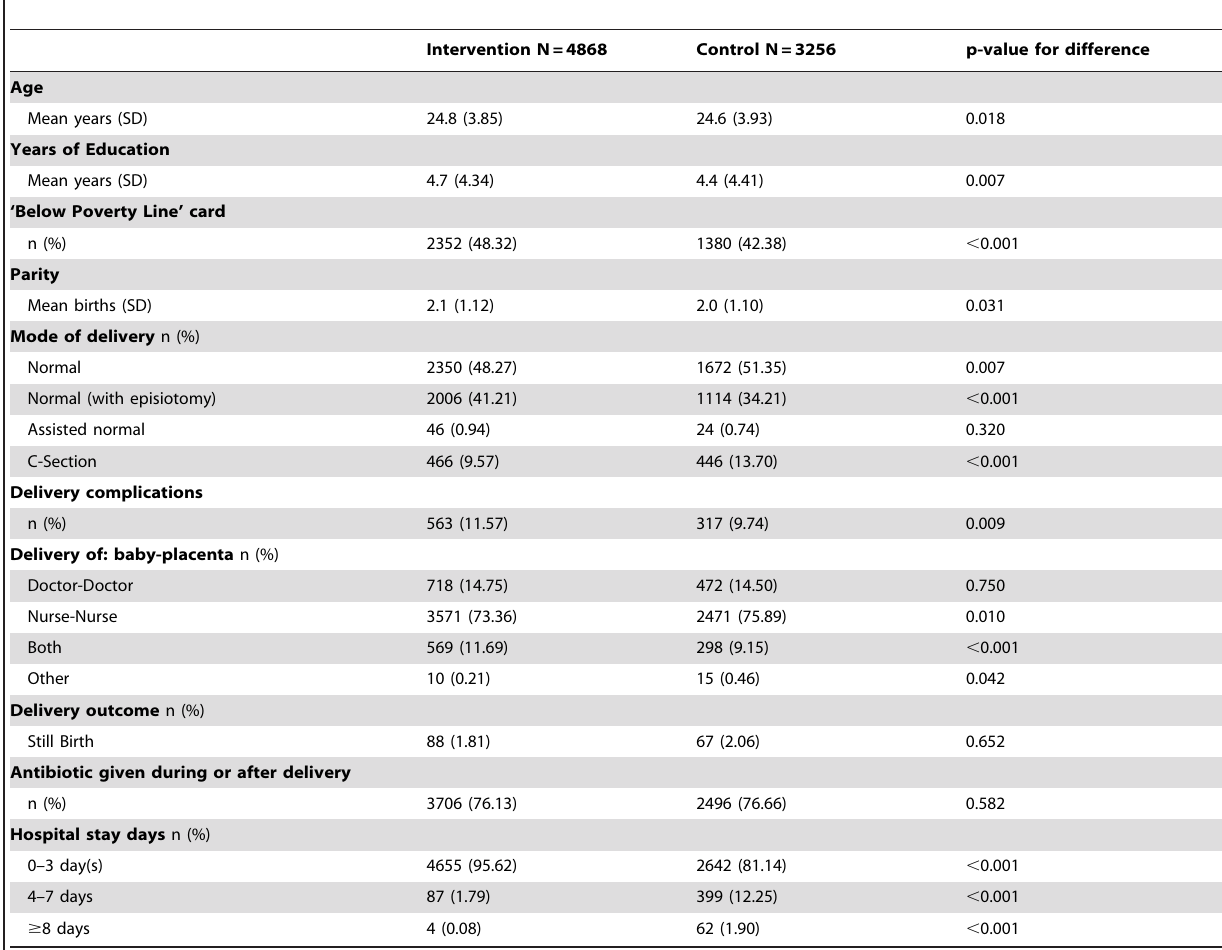
Table 3. Socio-economic, pregnancy and delivery characteristics of women in the sample.